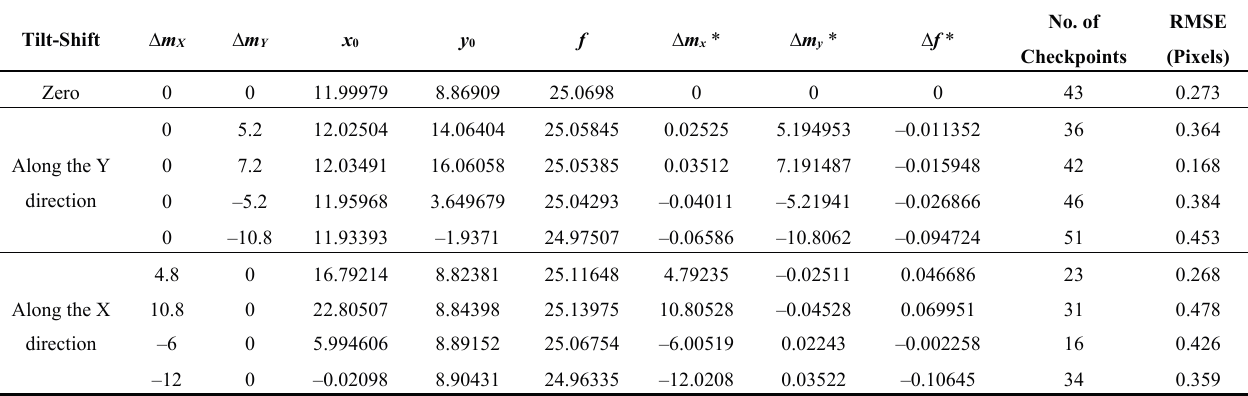
Table 4. IOEs of the camera in the tilt-shift experiment